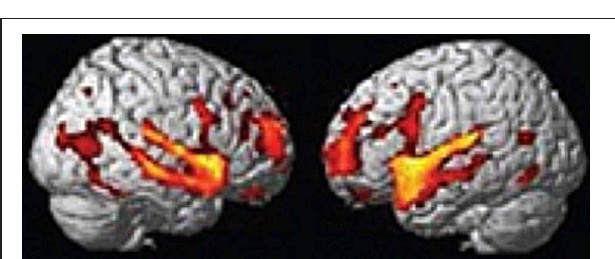
FIGURE 12 | From Segall et al. (2009) a large morphometric study of patients with schizophrenia or schizoaffective disorder and controls based on data from two consortiums with sites across the country (FBIRN and MCIC). Left panel shows right hemisphere and Right panel shows left hemisphere. The combined FBIRN and MCIC data set consists of 237 schizophrenic and 266 control subjects. Reprint of Figure 1, panel C with permission from the author from Segall et al.